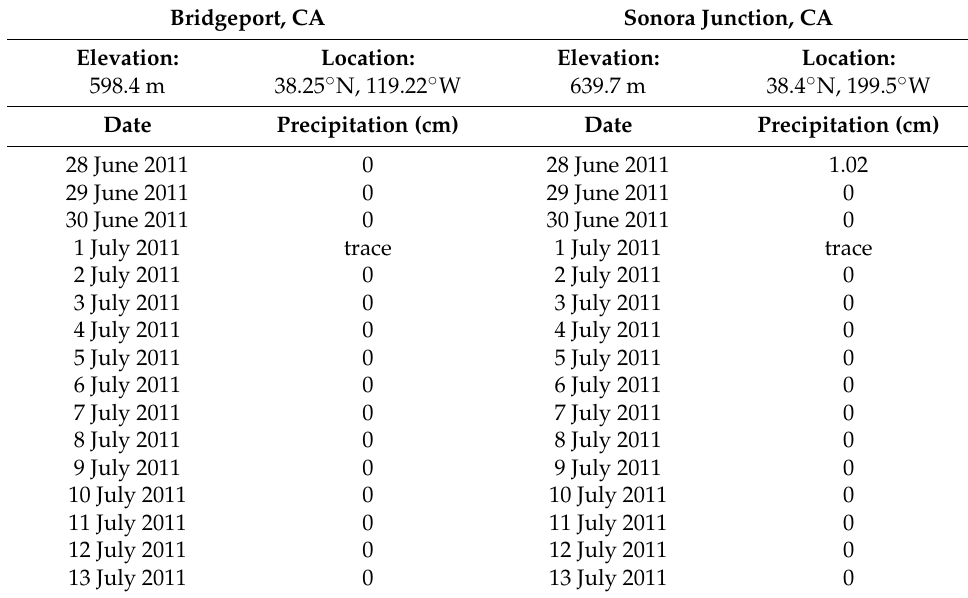
Table 1. Precipitation records for the closest weather stations to the Mono Craters (Sonora Junction, CA and Bridgeport, CA). Note the lack of rain before the ASTER overflights (10 July 2011) from which the ATI data are